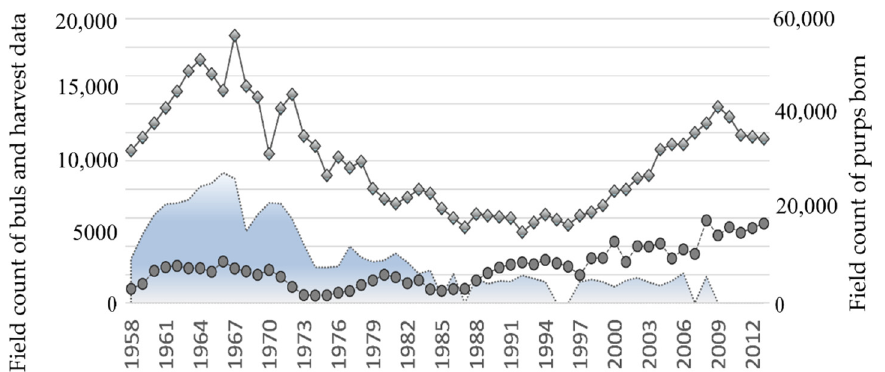
Figure 1. Field count of bulls before the harvest and number of males (including bulls and subadults from 2 to 6 years old) taken in the commercial harvest (on the left axis), and pups born (on the right axis) on Tyuleniy Island.